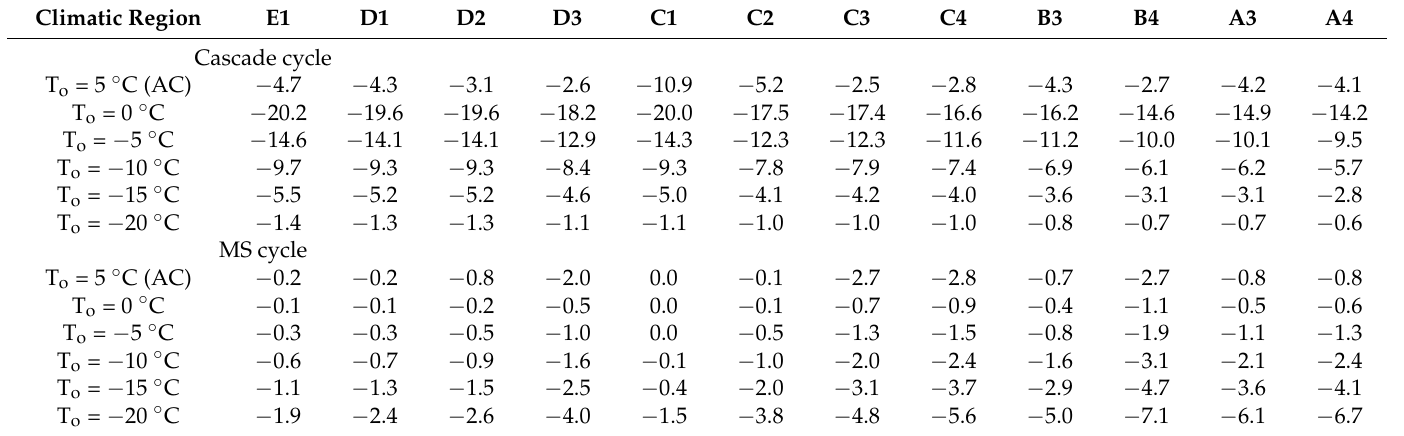
Table 3. Percentage deviation of annual COP values of MS and cascade cycles regards the best